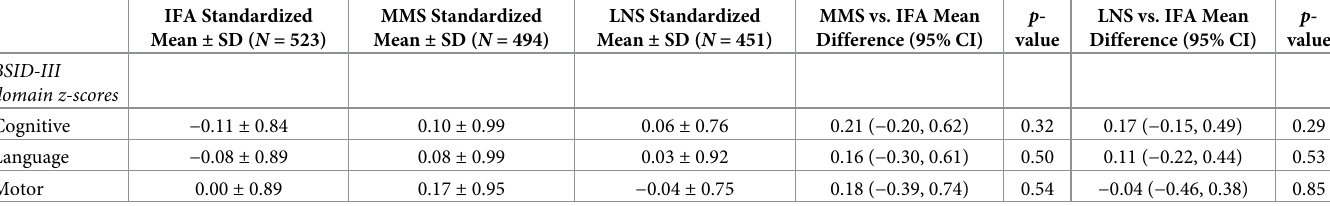
Table 2. Effect of randomized nutritional supplement group on BSID-III domain scores at 24 months of